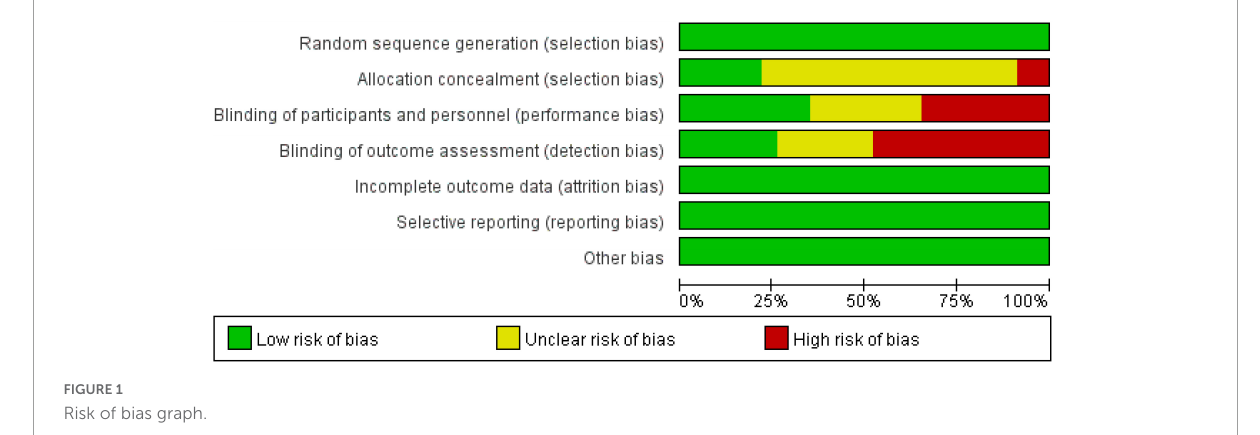
FIGURE1 Risk of bias graph.